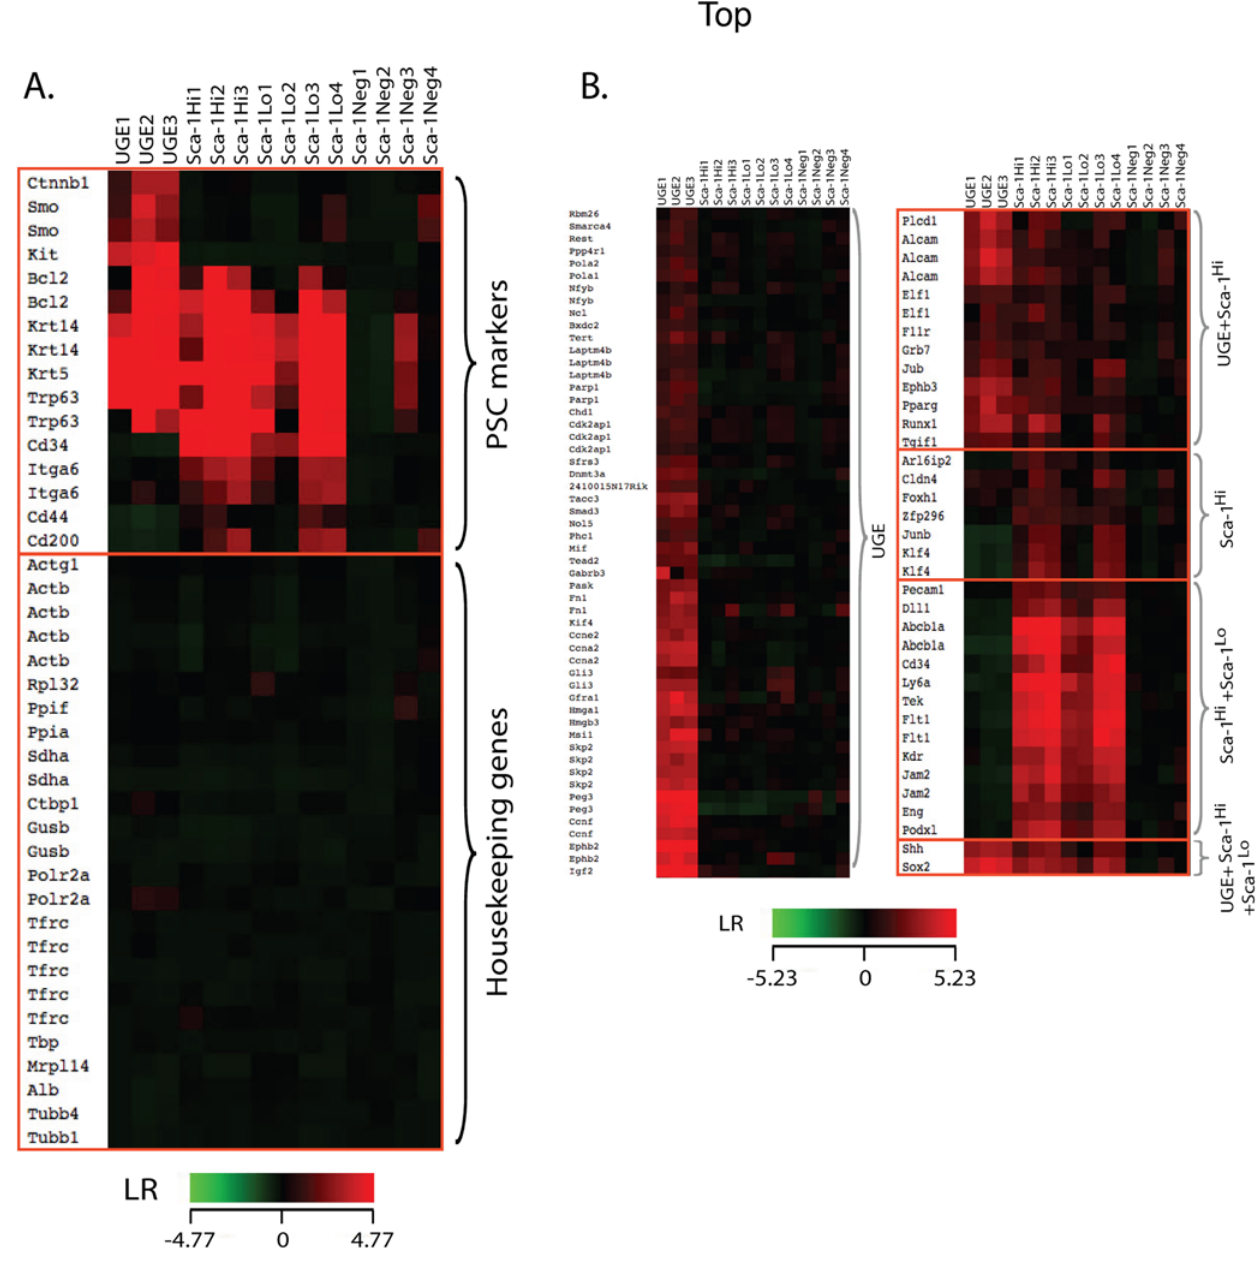
Figure 2. Known markers of primitive prostate (A) and stem (B) cells are expressed. A. Expression profiles of molecules described as being expressed in primitive prostate populations that were up-regulated at least 2-fold (upper panel) in the UGE, Sca-1 Hi and Sca-1 Lo cells are presented. Each column represents an individual sample, and each row represents a specific gene. Red (high), green (low) relative expression; black indicates equal expression relative to the Sca-1 Neg cells. The lower panel presents a cassette of 15 common murine housekeeping genes that manifest stable expression across all samples. Log ratio (LR) values are presented in Table S3 . B. Expression profiles of known SC markers ( eGOn and FatiGO survey), that were up-regulated by at least 2-fold in prostate stem/progenitor enriched samples. Five expression patterns can be distinguished. LR values are presented in Table S5 .